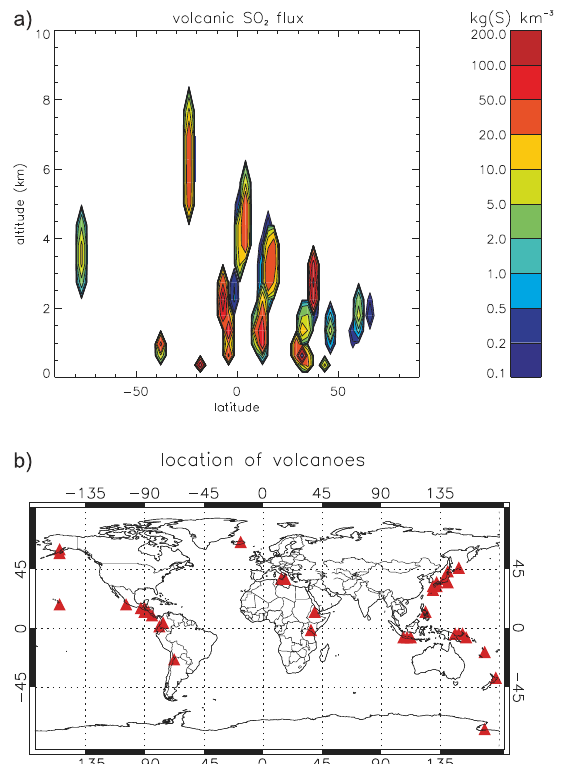
Fig. 2. Representation of the volcanic sulphur flux in GLOMAP-mode with (a) annual zonal mean volcanic SO 2 flux (kg ( S ) km − 3 a − 1 ) using the Andres and Kasgnoc (1998) inventory, and (b) geographical location of the volcanic